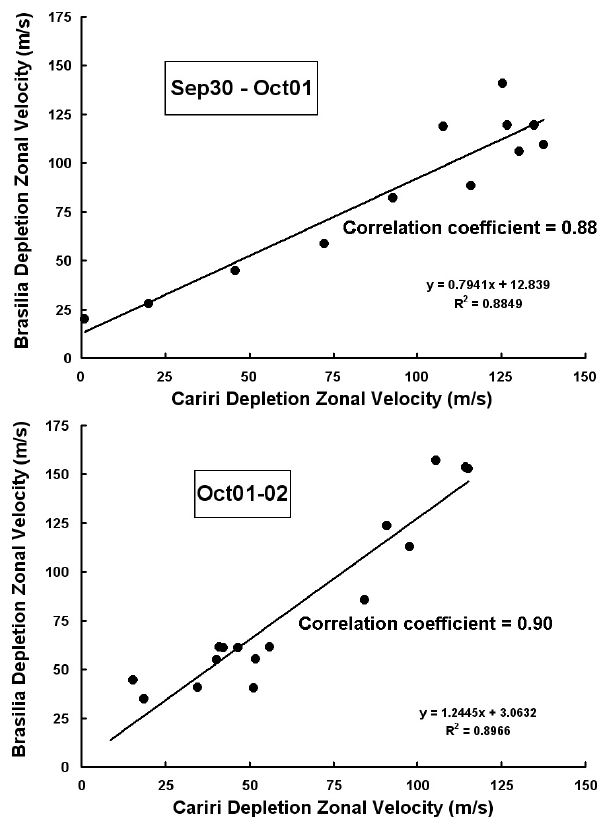
Fig. 9. Plots showing the correlation between the zonal drift veloc- ities of the depletions observed from Brasilia and Cariri during the nights of 30 September–1 October (a) and 1–2 October (b) . Note the different gradients.